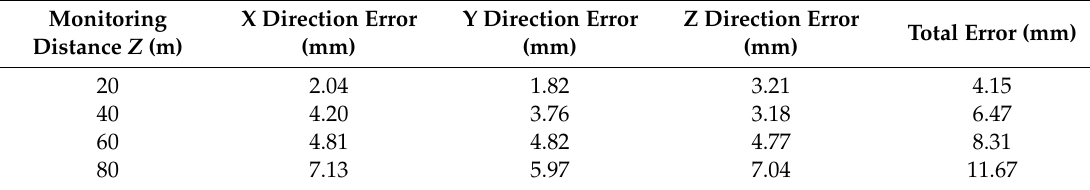
Table 5. The displacement error results measured by binocular vision measurement